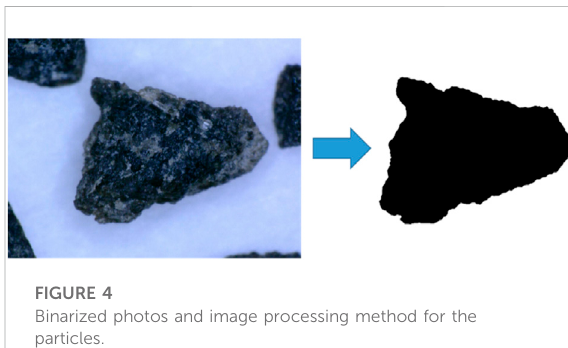
FIGURE 4 Binarized photos and image processing method for the particles.